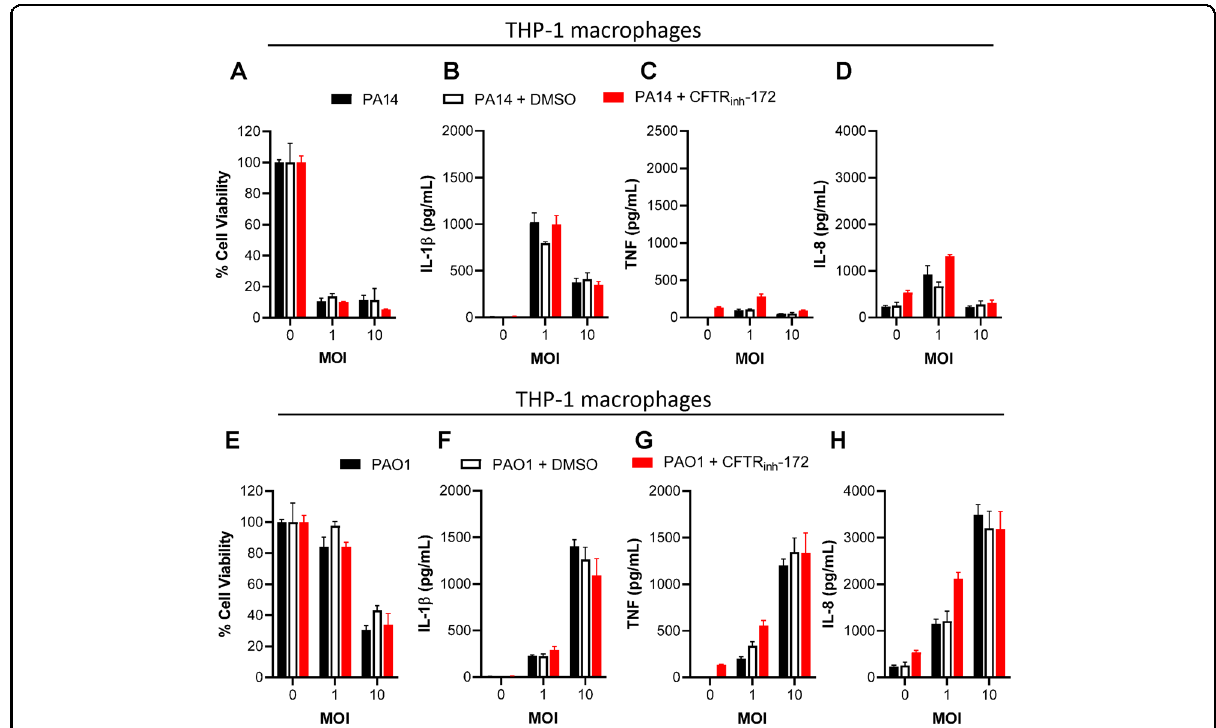
Fig. 7 CFTR inhibition in THP-1 macrophages does not impact cell death or cytokine production. THP-1 macrophages were seeded as described in Fig. 1 with the addition of either a DMSO vehicle control or 10 µM CFTR(inh)-172 overnight. In vitro infections were conducted with PA14 ( A – D ) or PAO1 ( E – H ) with the addition of either treatment. At 3 h postinfection, cell viability was evaluated by neutral red assay ( A , E ) and cytokine production was measured by ELISA ( B – D , F – H ). Mean ± SD of triplicates of a representative experiment are